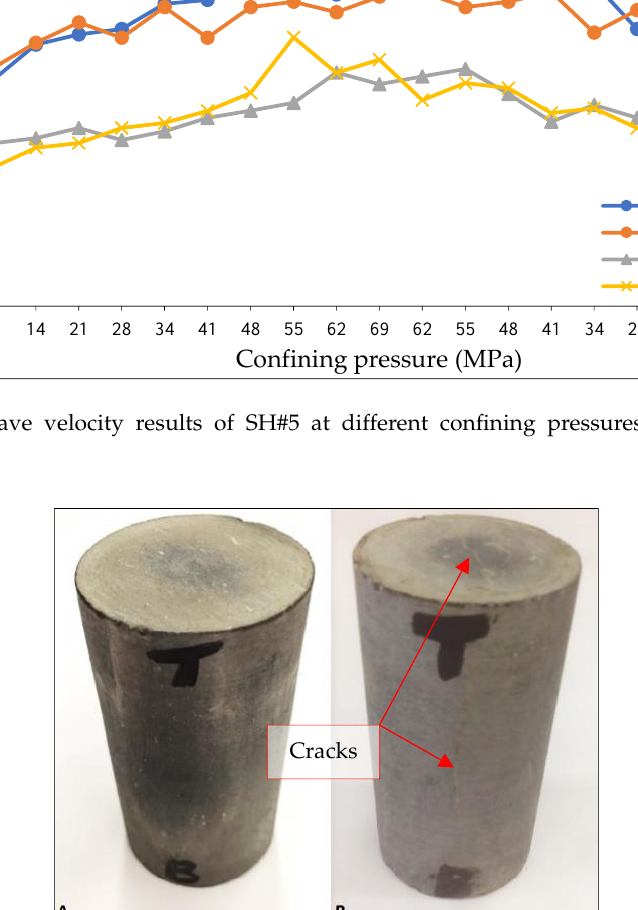
Figure 12. ( a ) Young’s modulus results of SH#5 at different confining pressures before and after thermal shock; and ( b ) Poisson’s ratio results of SH#5 at different confining pressures before and after thermal shock.